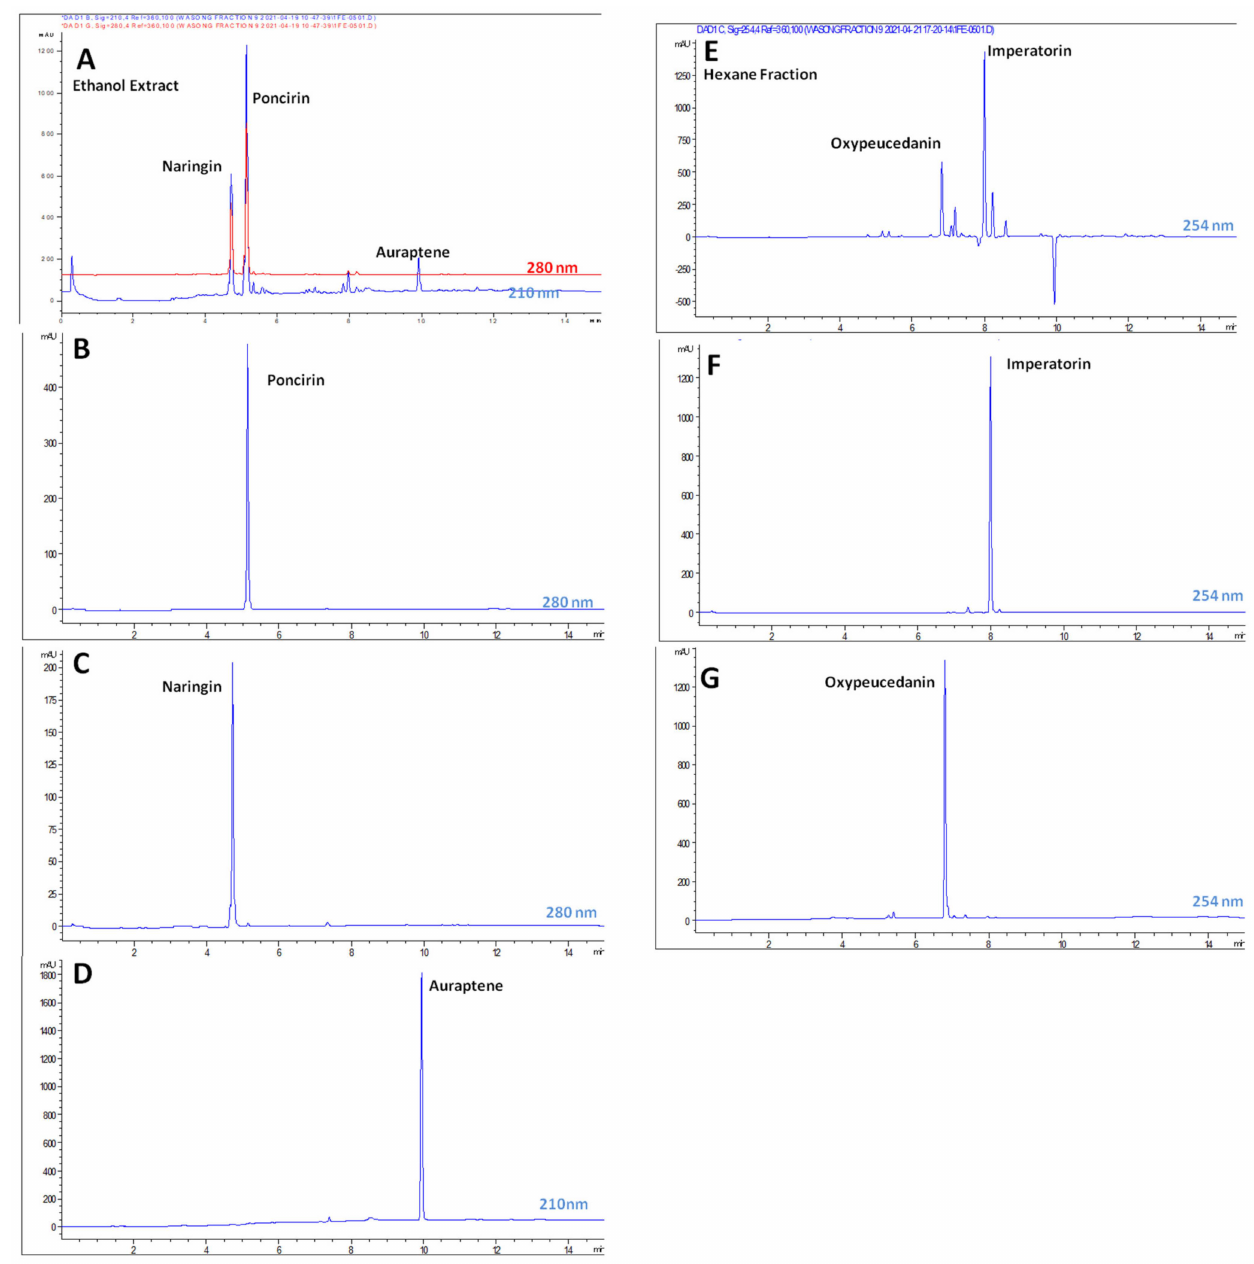
Figure 2. UPLC chromatograms of ethanol extract ( A ), poncirin ( B ), naringin ( C ), auraptene ( D ), hexane fraction ( E ), imperatorin ( F ) and oxypeucedanin ( G